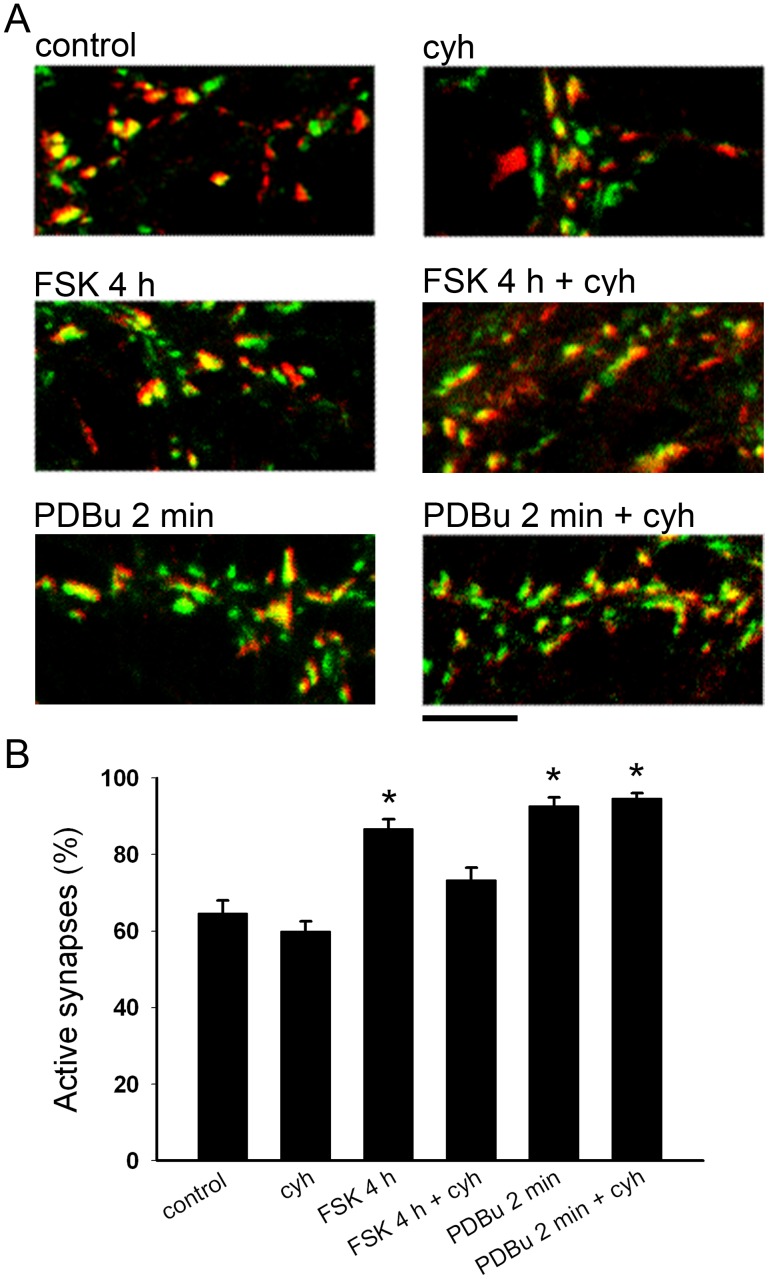
Unmuting of basally mute synapses by forskolin, but not PDBu, requires protein synthesis.
A. Representative FM1-43FX (green) and vGluT-1 (red) merged images after 4 h DMSO (control), 4 hr DMSO plus 1 µg/ml cycloheximide (cyh), 4 h 50 µM forskolin (FSK 4 h), 4 h 50 µM forskolin plus 1 µg/ml cycloheximide (FSK 4 h+cyh), 2 min 1 µM PDBu (PDBu 2 min), or 2 min 1 µM PDBu plus 1 µg/ml cycloheximide (PDBu 2 min+cyh) treatment. Cycloheximide was applied 0.5 h prior to and during treatments. Scale bar represents 5 µm. B. Quantification of the percentage of vGluT-1-defined synapses labeled with FM1-43FX (active synapses) after treatments described in panel A (n = 20 fields). *p<0.05, Bonferroni corrected Student’s unpaired t test vs. control.